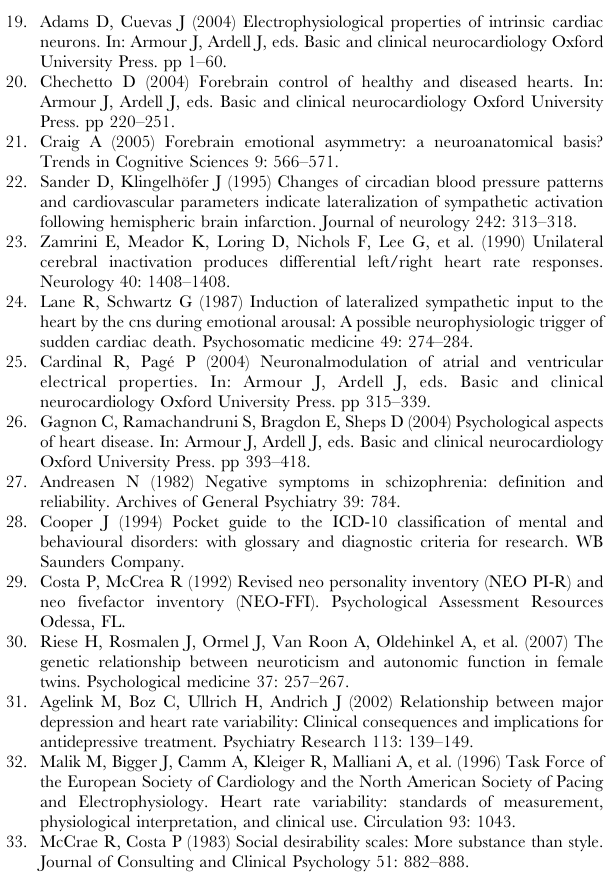
Table S3 Standardized canonical discrimination coeffi- cients. The dependent variables of the discriminant analyses were